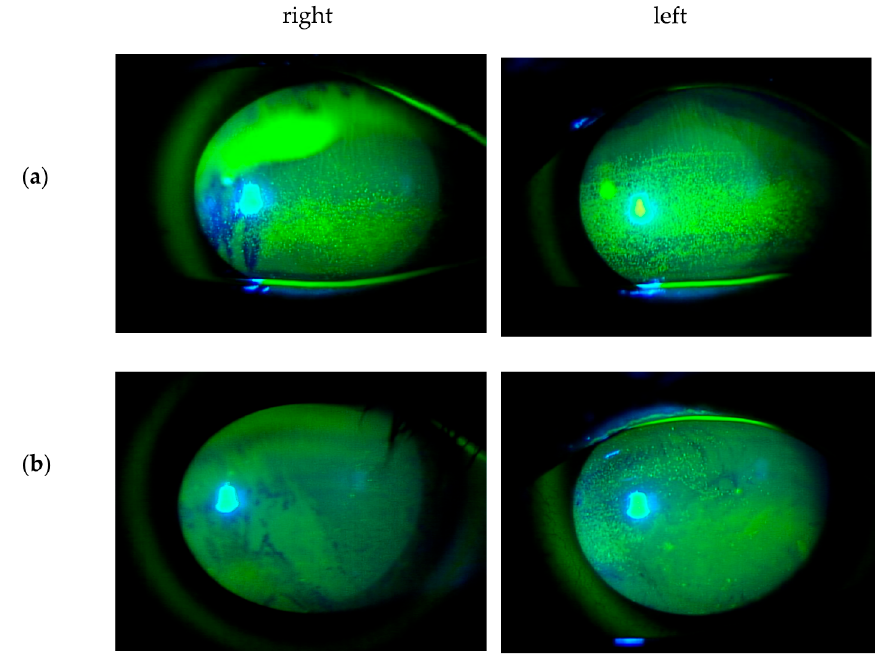
Figure 4. Slit-lamp images of the corneal surface with fluorescein staining in dry eye induced by Pembrolizumab (anti-PD1 antibody) . A 44-year old man with metastatic lung cancer from a primary kidney cancer was referred to the ocular inflammation service, Nippon Medical School Hospital, for bilateral red eyes. he was undergoing his second cycle of Pembrolizumab (anti-PD1 antibody). ( a ) He had bilateral punctate epithelial erosions with moderate fluorescein staining. The basic tear secretion test was 0 mm in the right eye and 3 mm in the left eye. His examination revealed Vogt–Koyanagi–Harada (VKH)-like syndrome, hepatic dysfunction, hypopituitarism, and adrenal dysfunction as irAEs. Pembrolizumab was discontinued. He was administered oral hydrocortisone (25 mg/day) for his adrenal dysfunction. At 12 weeks after topical artificial tears and topical rebamipide (2%), his dry eye gradually improved and showed ( b ) only minimal fluorescein staining of punctate epithelial erosions with the basic tear secretion test 20 mm in the right eye and 15 mm in the left eye.